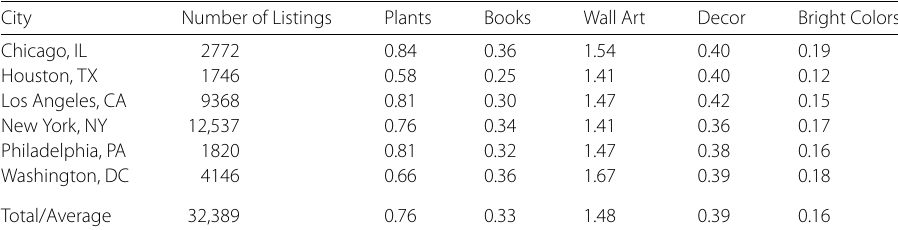
Table 5 Average interior element frequency across selected U.S. cities City Number of Listings Plants Books Wall Art Decor Bright Colors Chicago,